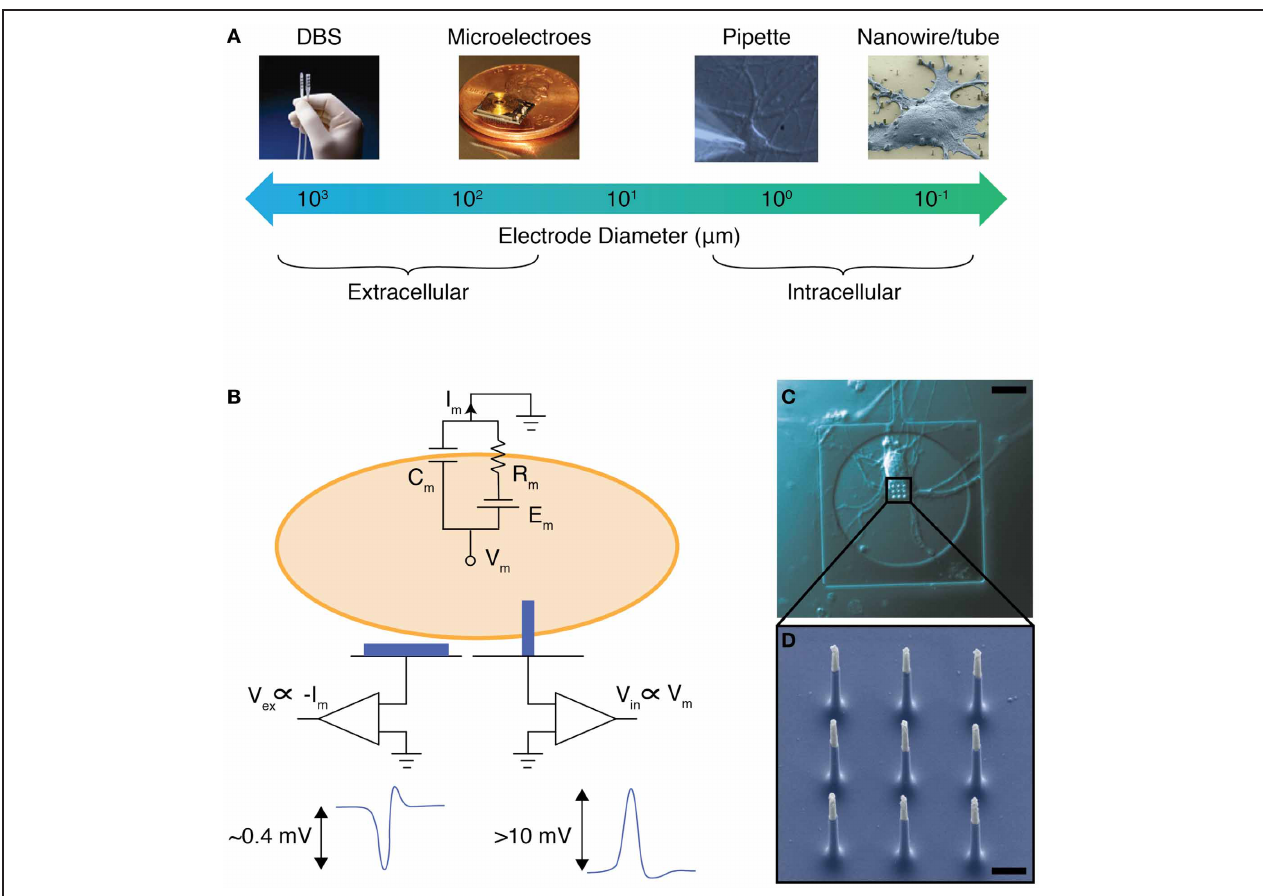
(V ex ) is proportional to I m , and typically has a magnitude of 0.4mV for a neuronal action potential. The voltage recorded intracellularly (V in ), however, is proportional to V m , and typically has a magnitude of greater than 10mV for a neuronal action potential. (C) Optical microscope image of a rat cortical neuron grown on top of a vertical NW electrode, scale bar 10 microns. (D) Scanning electron micrograph of a set of vertical NWs, scale bar 1 micron. [ (C) and (D) adapted from Robinson et al.